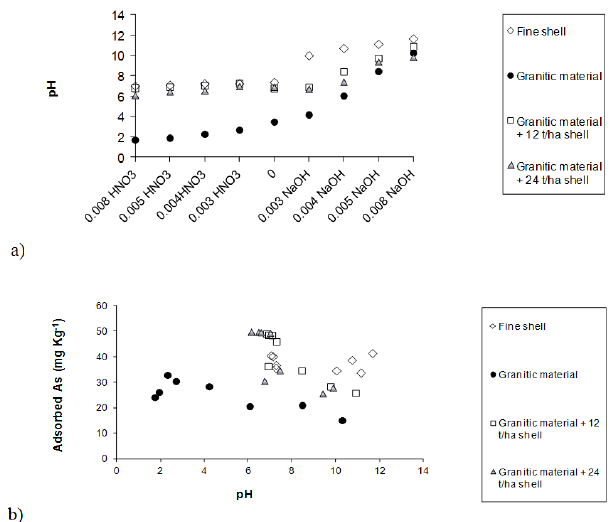
Figure 3. (a) Time-course evolution of pH for the solid materials as a function of the various molar concentrations of added HNO 3 and NaOH; (b) relationship between adsorption (mgkg − 1 ) and pH value for fine shell and the unamended and shell-amended granitic material. Average values for three replicates, with coefficients of variation always <